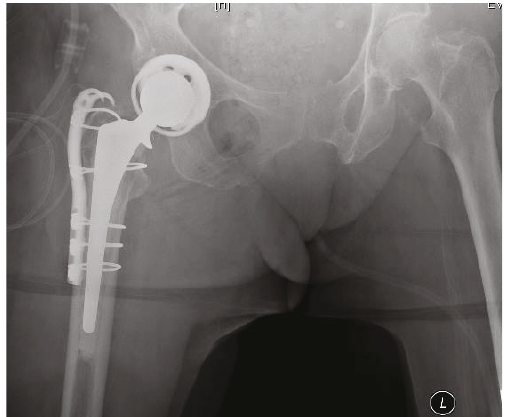
Figure 5: Anteroposterior (AP) pelvis radiograph, status post right hip open reduction, revision total hip arthroplasty with constrained liner and greater trochanteric hook plate with cerclage cables.